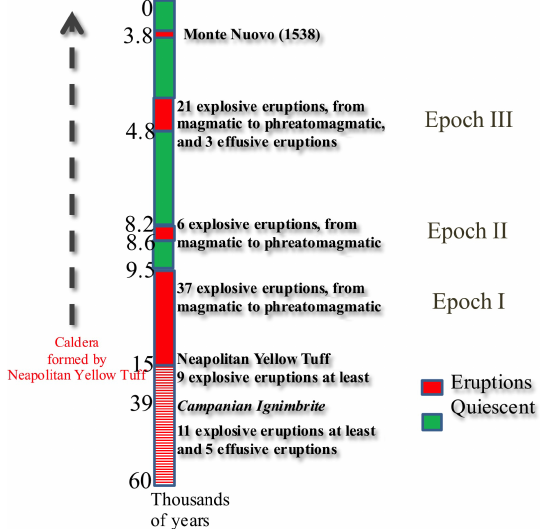
Figure 6. Eruptive history of Campi Flegrei caldera. Note that, ac- cording to recent results (De Natale et al., 2016; Rolandi et al., 2019b) the Campi Flegrei caldera was formed by Neapolitan Yel- low Tuff (15kyrBP), and only hosted secondary events of the Cam- panian Ignimbrite (39kyrBP) whose main vents opened north of Campi Flegrei area (in the Campanian